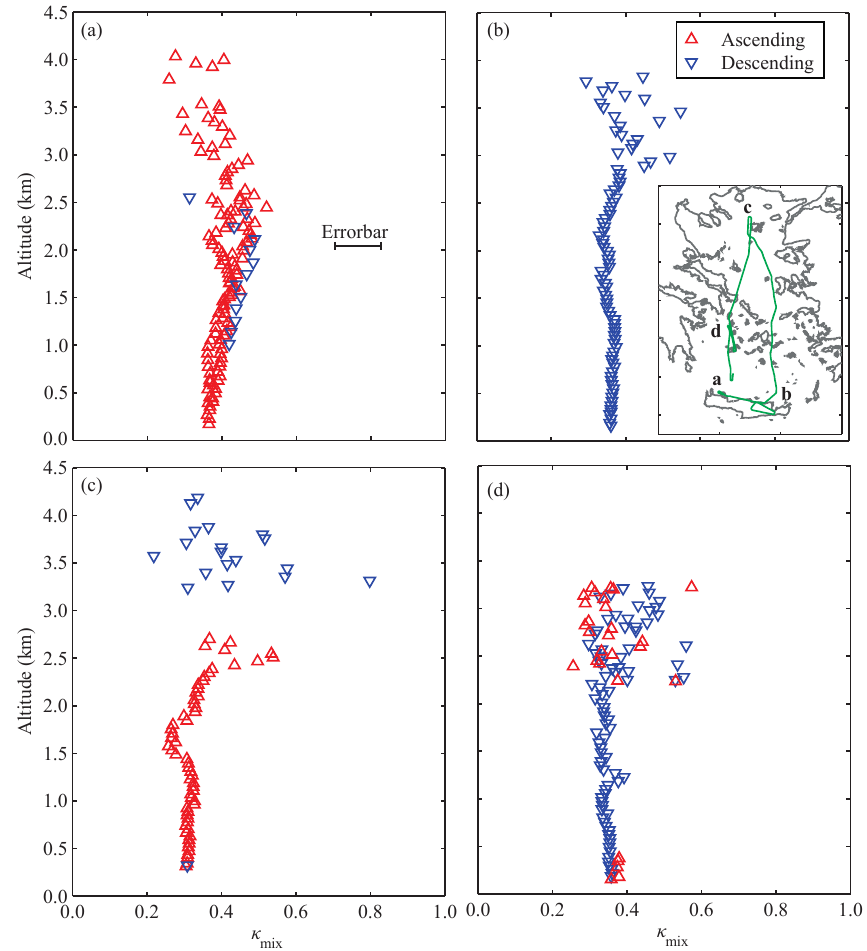
Fig. 10. Vertical profiles of the estimated hygroscopic parameters κ mix of aerosol particles observed over southwestern (a) southeastern (b) , central (c) and northern (d) Aegean Sea, during ascends (up triangles) and descends (down triangles) performed on the flight of 4 September 2011 (flight b641). The inset shows the locations corresponding to the vertical profiles of κ mix , shown in the different subplots. The hy- groscopic parameters are calculated using the κ -Köhler theory (Eq. 3) and the bulk chemical composition measurements from the airborne cToF-AMS. For the calculations we assumed that the particles were internally mixed, and that all the organic species had κ org = 0 . 1 and ρ org = 1400kgm − 3 . The error bar represents the spread of the estimated κ mix values when adopting the level of uncertainty used in our closure